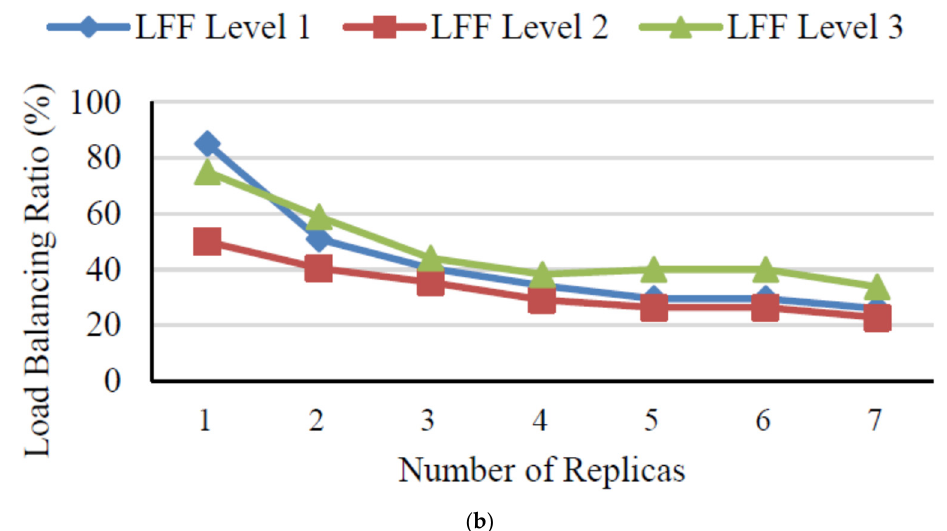
Figure 5. Load balancing ratio: ( a ) When adopting the VNFRP algorithm, and ( b ) The corresponding values when adopting the LFF strategy.